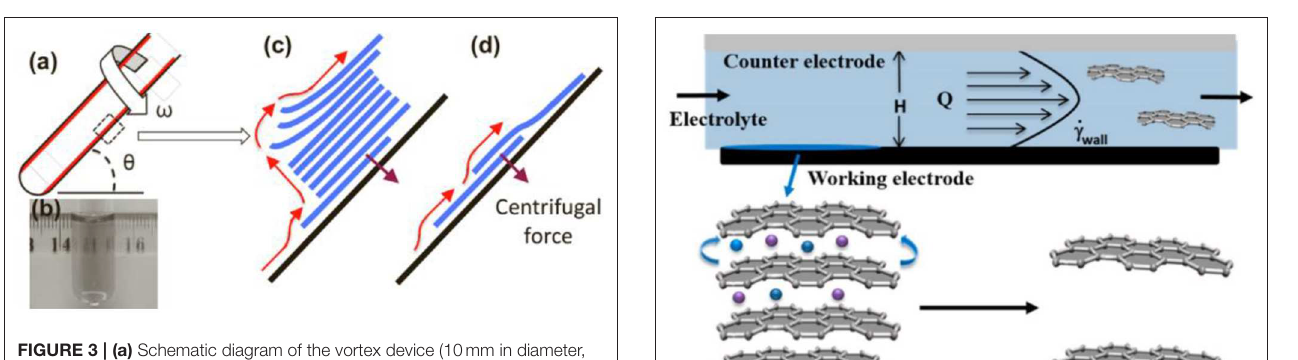
FIGURE 3 | (a) Schematic diagram of the vortex device (10mm in diameter, 16cm long, 45 ◦ inclined, graphite running at 7,000 rpm). (b) Photograph of a colloidal suspension of graphene obtained in NMP. (c) Schematic diagram of the stripping process. (d) Sliding on the inner surface of the rotating tube; the red arrow indicates the direction of the shear flow.